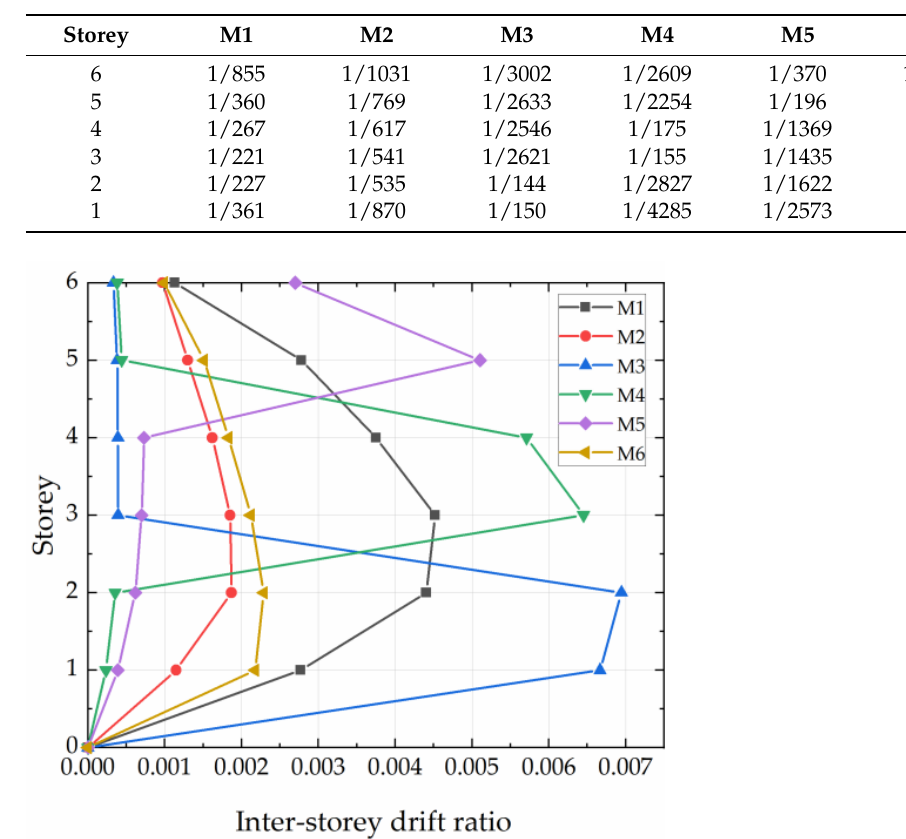
Table 9. The interstorey drift ratio of models at the performance point.